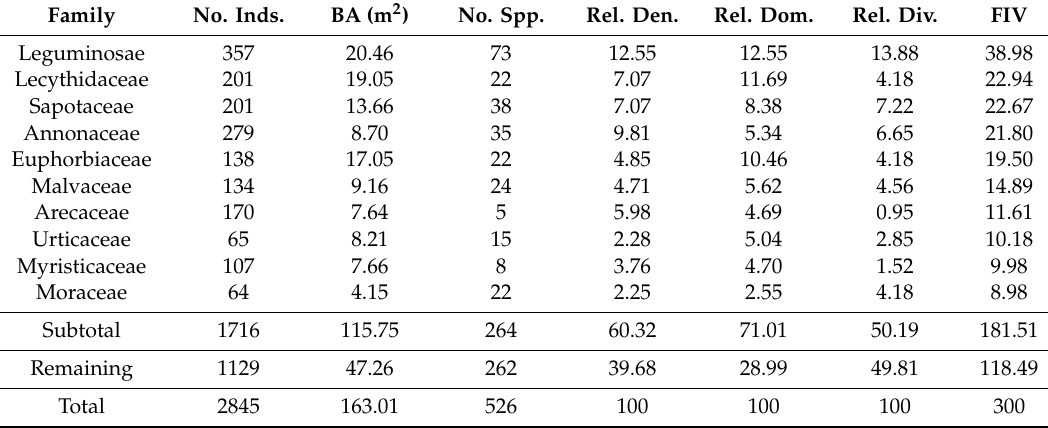
Table 4. The ten most important v á rzea families listed in descending order of family importance value (FIV). Values are based on all woody plants with species identifications. The number of individuals (No. Inds.) and the number of species within each family (No. Spp.) are given as counts. Basal area (BA) in m 2 . Relative density (Rel. Den.), relative dominance (Rel. Dom.) and relative diversity (Rel. Div.) are given as percentages, where 100 equals 100% (Supplementary Table